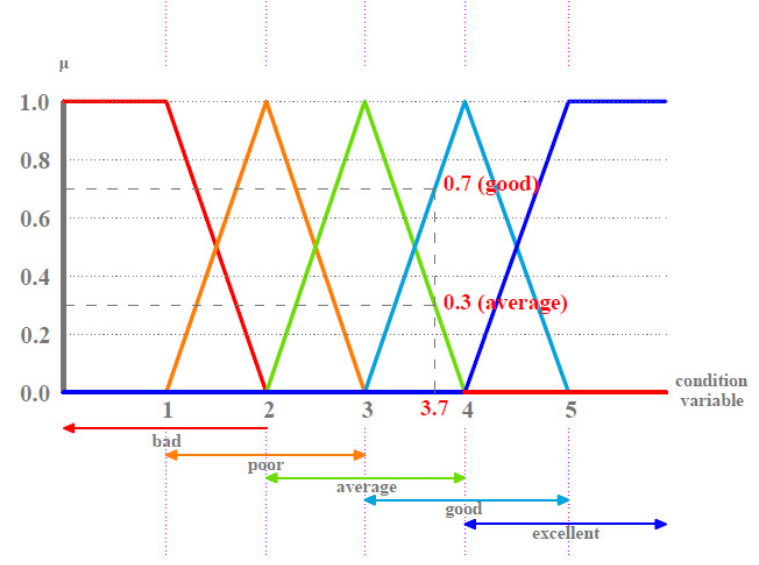
Figure 4. Example of a triangular membership function with the corresponding condition scale.